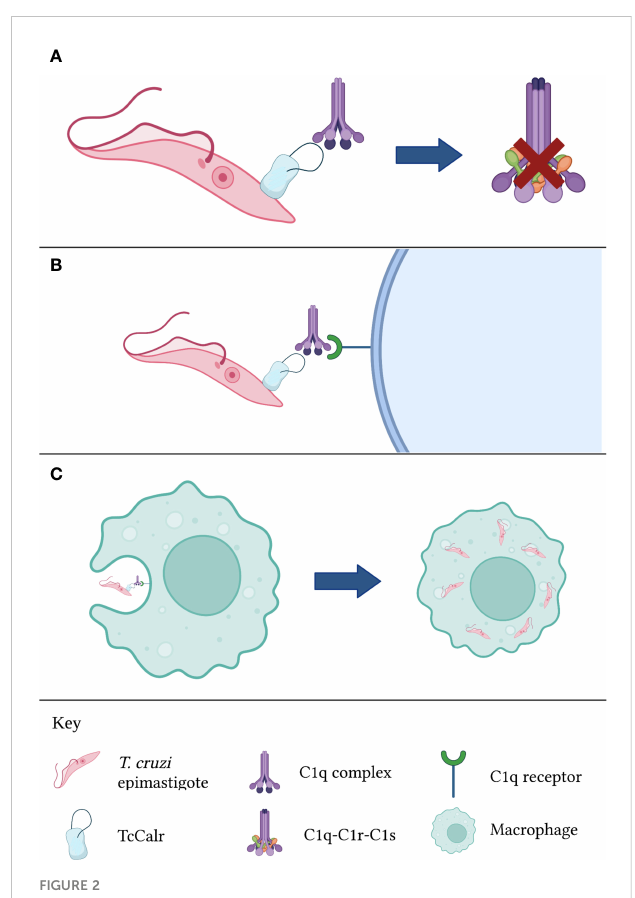
FIGURE 2 Calr from T. cruzi is inhibits complement activation. (A) TcCalr binds to C1q and impeding C1r and C1s proteolysis. (B) Once the TcCalr- C1q complex is formed, it is recognized by C1q receptors expressed on the surface of phagocytes. (C) Upon recognition, phagocytes engulf the epimastigote, promoting infectivity. TcCalr: Trypanosoma cruzi